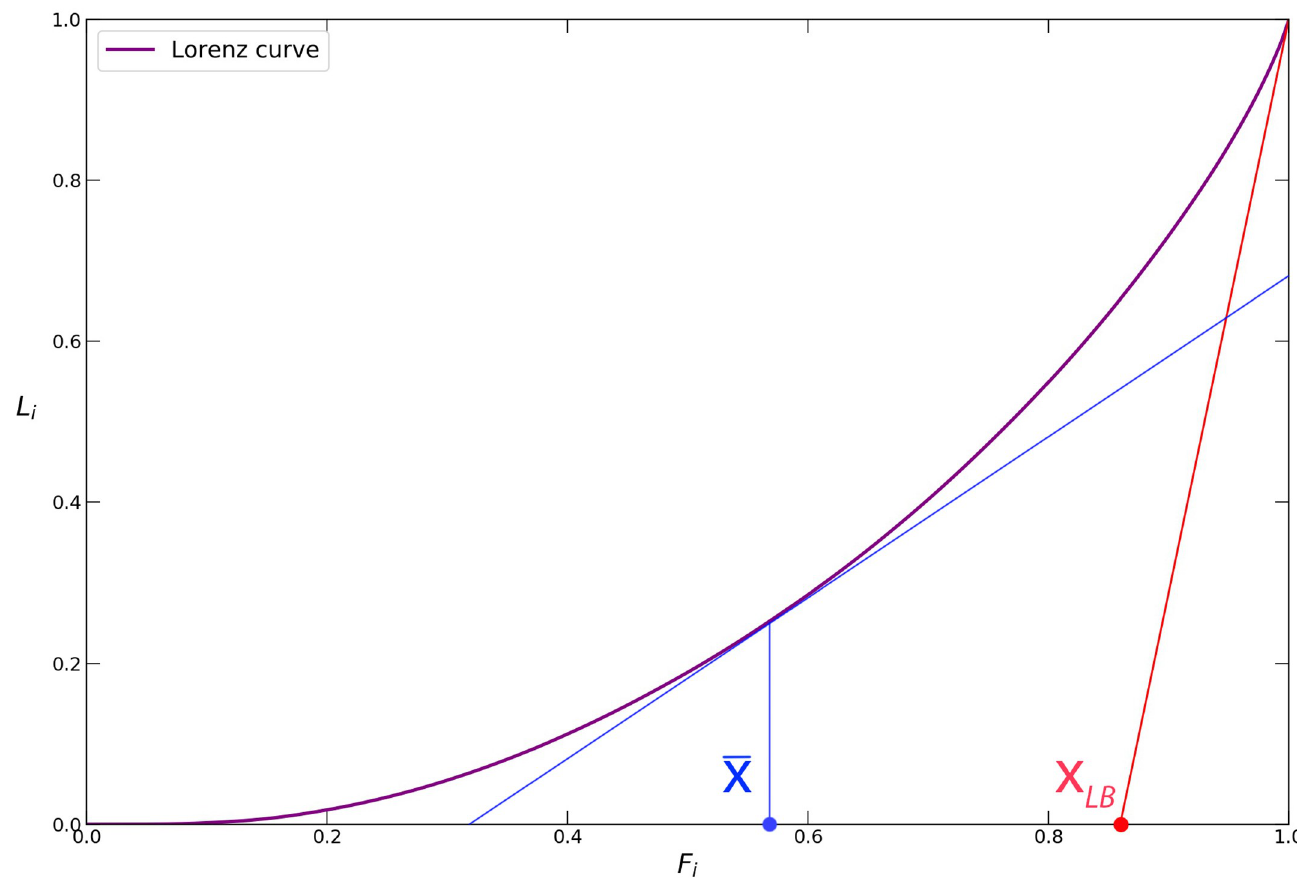
Fig 9. Lorenz curve for a data